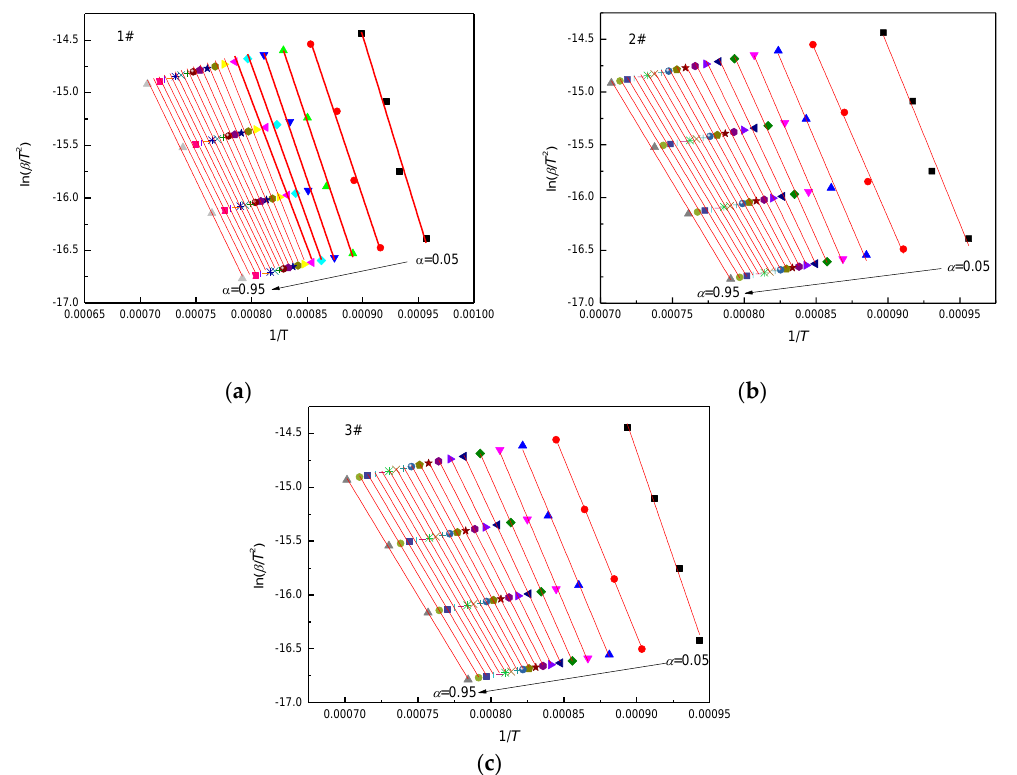
Figure 5. Graphical representation based on the integral isoconversional model of Miura–Maki for samples with different particle sizes: ( a ) 1#, ( b ) 2#, and ( c ) 3#. The plot of ln( β /T 2 ) vs. 1/T for the constant gasification conversion factor ( α ) resulted in a straight line with the slope of −E/R and intercept of ln(k 0 R/E) + 0.6075 as presented in Figure 5. The values of activation energy ( E ), pre-exponential factor ( k 0 ), and correlation coefficient ( R 2 ) estimated from the integral isoconversional model of Miura–Maki is presented in Table 3. Table 3 shows that the values